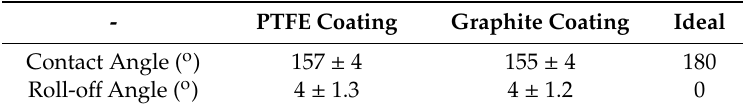
Table 4. Roll-o ff and contact angle